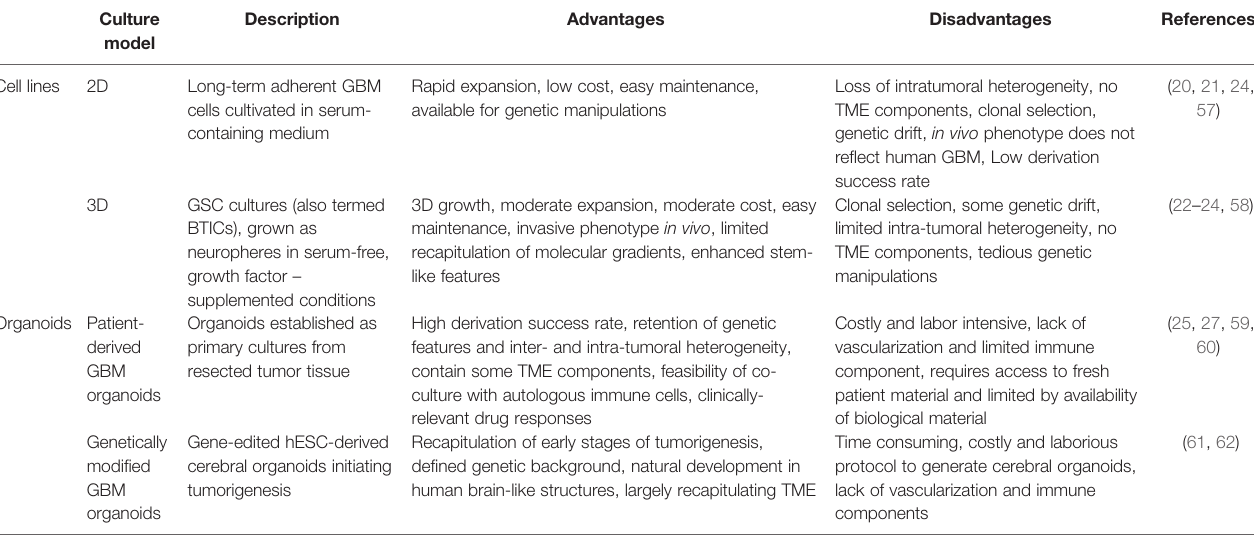
TABLE 1 | Overview and comparison of GBM culture